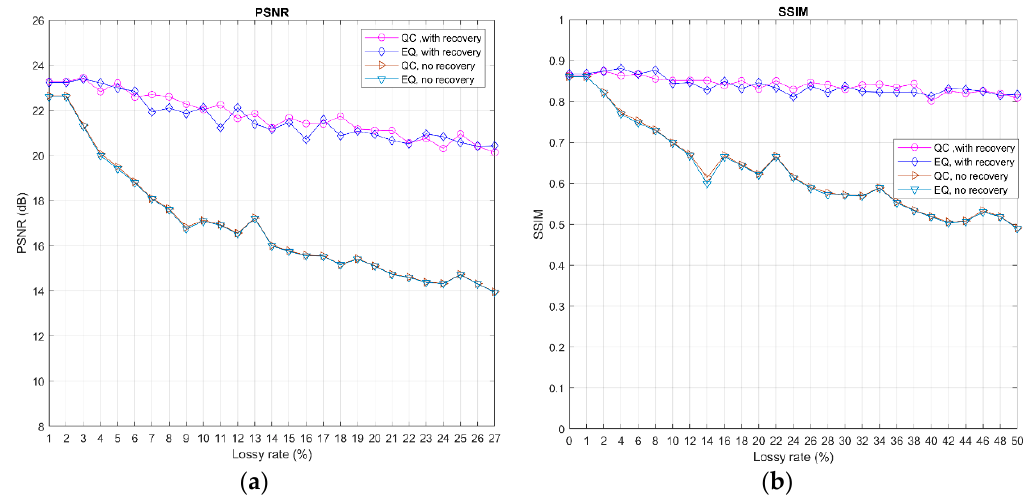
Figure 11. Reconstructions for EQ and QC constraints for ducks with different lossy probabilities: ( a ) PSNR curves and ( b ) SSIM curves.